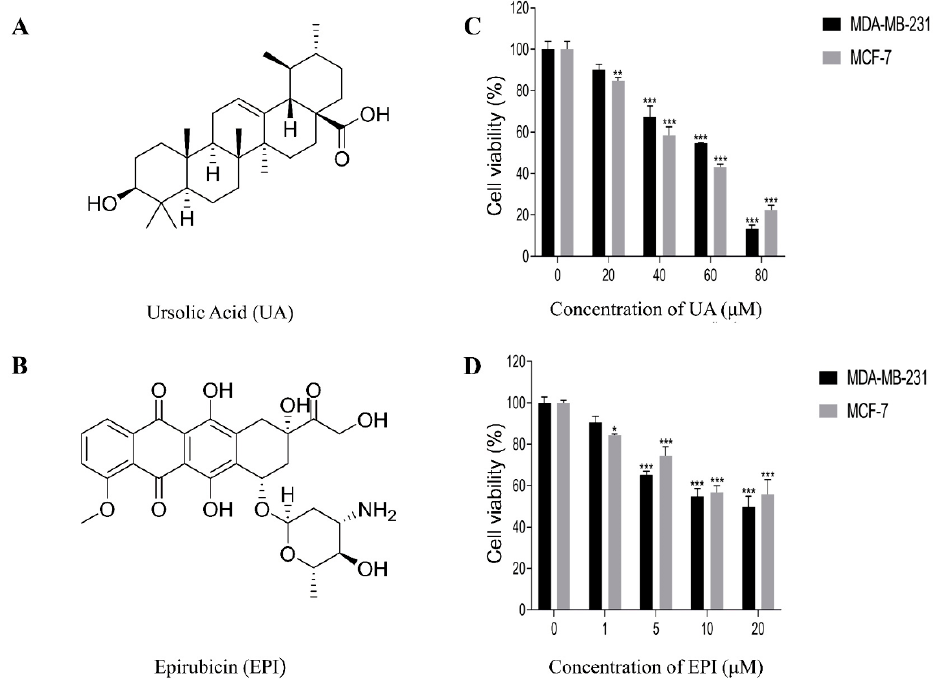
Figure 1. Chemical structures of Ursolic Acid ( A ) and Epirubicin ( B ). The effects of UA or EPI on cell viability were determined by CCK-8 assay. ( C ) MCF-7 and MDA-MB-231 cells were treated with the indicated concentrations of UA for 24 h. ( D ) MCF-7 and MDA-MB-231 cells were treated with the indicated concentrations of EPI for 24 h. The means and SEM were shown. n = 3. * p < 0.05, ** p < 0.01 and *** p < 0.001 versus cells without drug treatment.